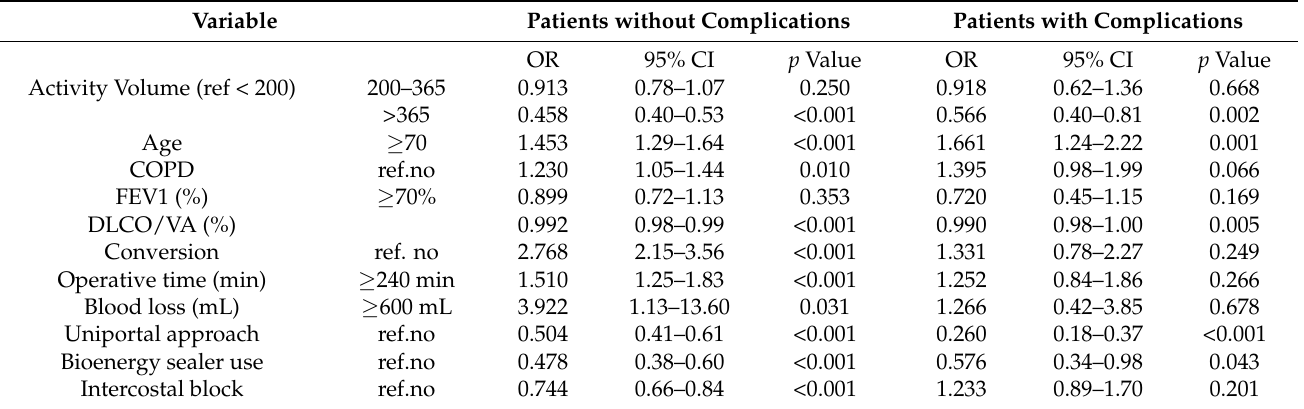
Table 8. Multiple logistic regression analysis of the effects of the independent variables on hospital stay based on the presence or absence of